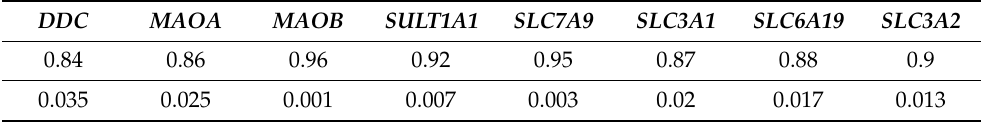
Figure 2. Functional scheme summarizing the predicted dopamine/trace amines metabolic pathways taking place in human enterocytes of the small intestine. This scheme is based on the mining of human expression atlases and on previously published biochemical and/or functional data obtained in intestinal or non-intestinal cells. The molecules included in this scheme comprise: angiotensin-converting enzyme 2 (ACE2), solute carrier family 6 member 19 (SLC6A19), solute carrier family 3 member 1 (SLC3A1), solute carrier family 7 member 9 (SLC7A9), dopa-decarboxylase (DDC), sulfotransferase family 1A member 1 (SULT1A1), sulfotransferase family 1A member 2 (SULT1A2), sulfotransferase family 1A member 3 (SULT1A3), cytochrome P450 family 2 subfamily D member 6 (CYP2D6), monoamine oxidase A (MAOA), monoamine oxidase B (MAOB), solute carrier family 3 member 2 (SLC3A2), solute carrier family 7 member 8 (SLC7A8) and solute carrier family 6 member 10 (SLC16A10). Table 3. Correlation analysis of ACE2 mRNA levels with key genes of the dopamine/trace amines metabolic pathways in SARS-CoV2-infected human